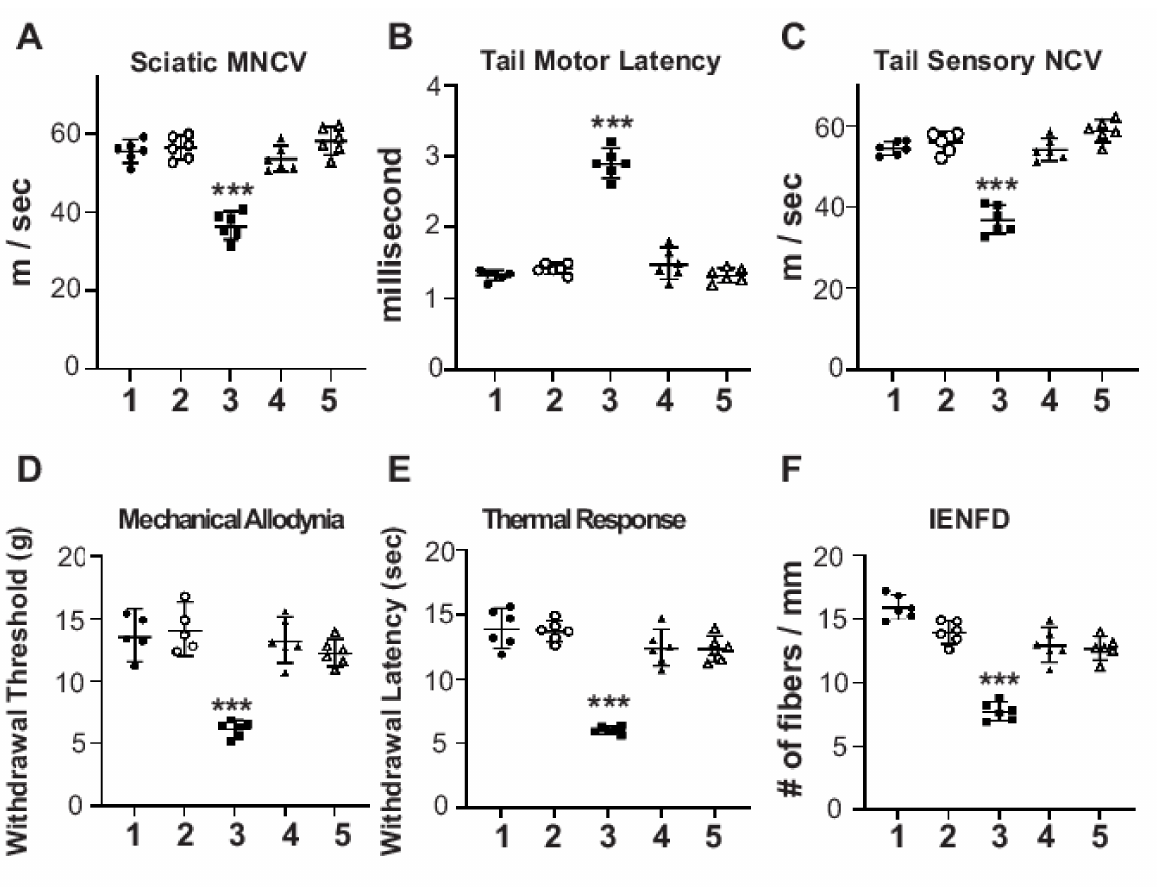
Figure 1. NMN prevents STZ-induced neuropathy in SD rats ( n = 6/group). Thirty male SD rats were randomly assigned to five groups of six rats per group. Group # 1: non-diabetic (non-Dia); Group # 2: non-diabetic with NMN (non-Dia + NMN) (100 mg/kg); Group # 3: streptozotocin (STZ); Group # 4: streptozotocin with NMN (STZ + NMN) (50 mg/kg); and Group # 5: streptozotocin with NMN (STZ + NMN) (100 mg/kg). Injections (IP) of saline and NMN were administered on alternate days for 2 months. Rats were tested for the following parameters: SMNCV ( A ), TML ( B ), TSNCV ( C ), mechanical allodynia by von Frey filament paw withdrawal threshold ( D ), paw thermal sensitivity by Hargreaves test ( E ), and IENFD of the hind paw ( F ). Statistical comparisons were made between the five groups by ANOVA and post hoc Tukey test. *** p < 0.001; STZ, Group # 3 at 2 months compared to all other groups in all